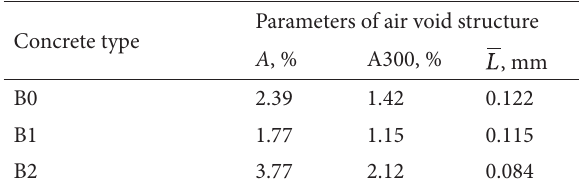
Table 6. Air void characteristics of hardened concrete Series B according to PN-EN 480-11:2008